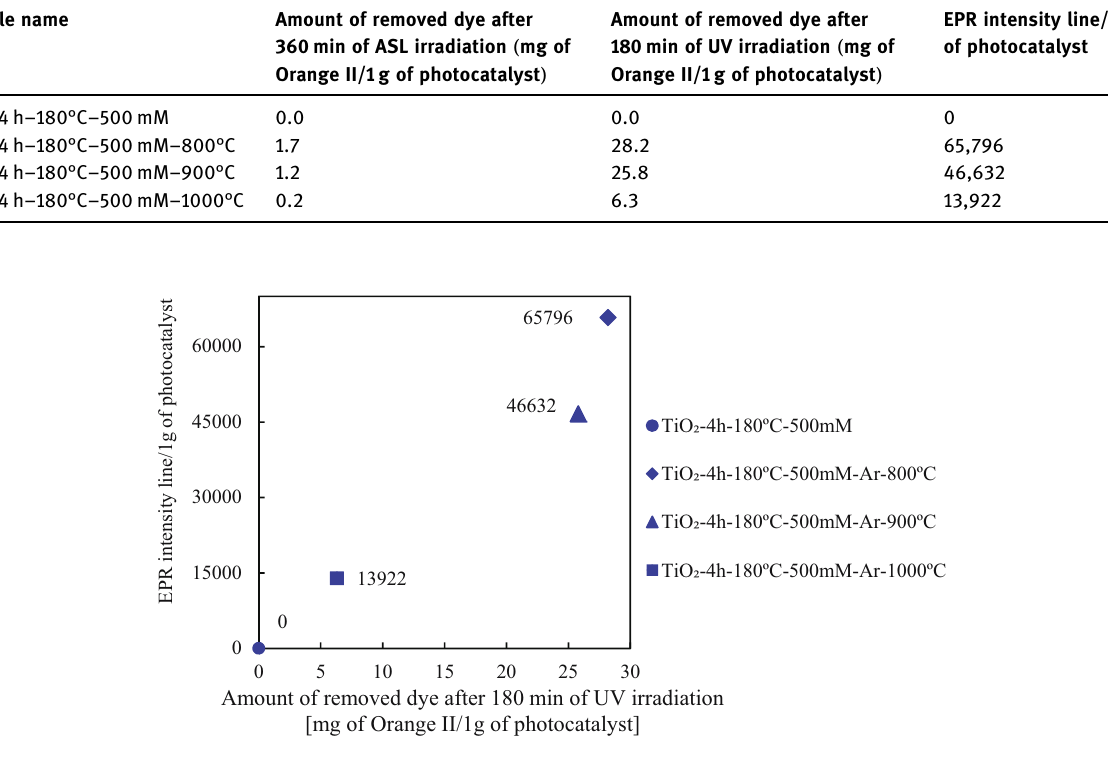
Figure 4: Correlation between the amount of Orange II dye removed after 180 min of UV irradiation and EPR line intensity for APTES/TiO 2